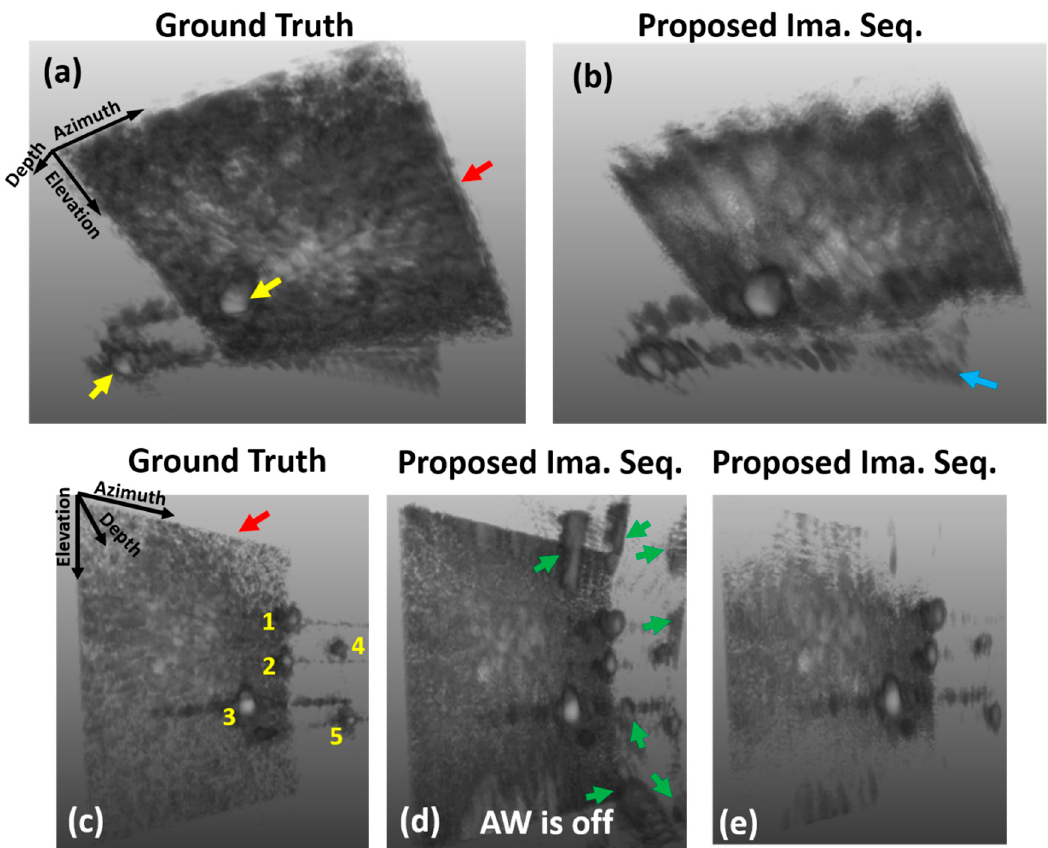
Figure 10. The 3D images obtained with ( a , c ) the CBC imaging sequence (GT) and ( b , d , e ) the proposed imaging sequence (full-aperture transmission, Nr = 5 and Ns = 3). The red, yellow, green, and blue arrows show the foam, the two needles, the grating lobes, and the clutter in the azimuth direction, respectively. The dynamic range was 40 dB. The numbers in ( c ) are related to those shown in Figure 3e.